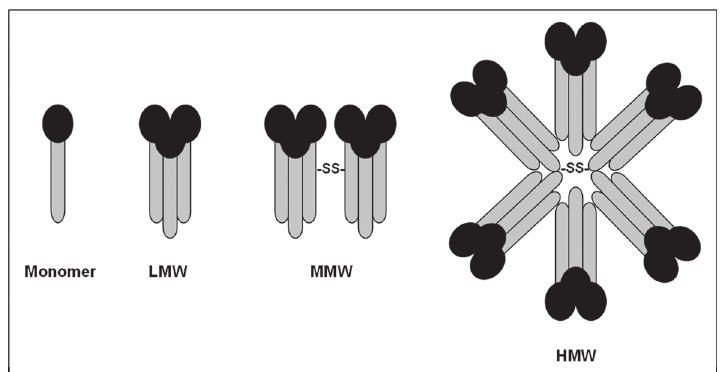
Figure 2. Representation of the circulating adiponectin forms. LMW = low mo- lecular weight; MMW = middle molecular weight; HMW = high molecular weight; SS = disulfide